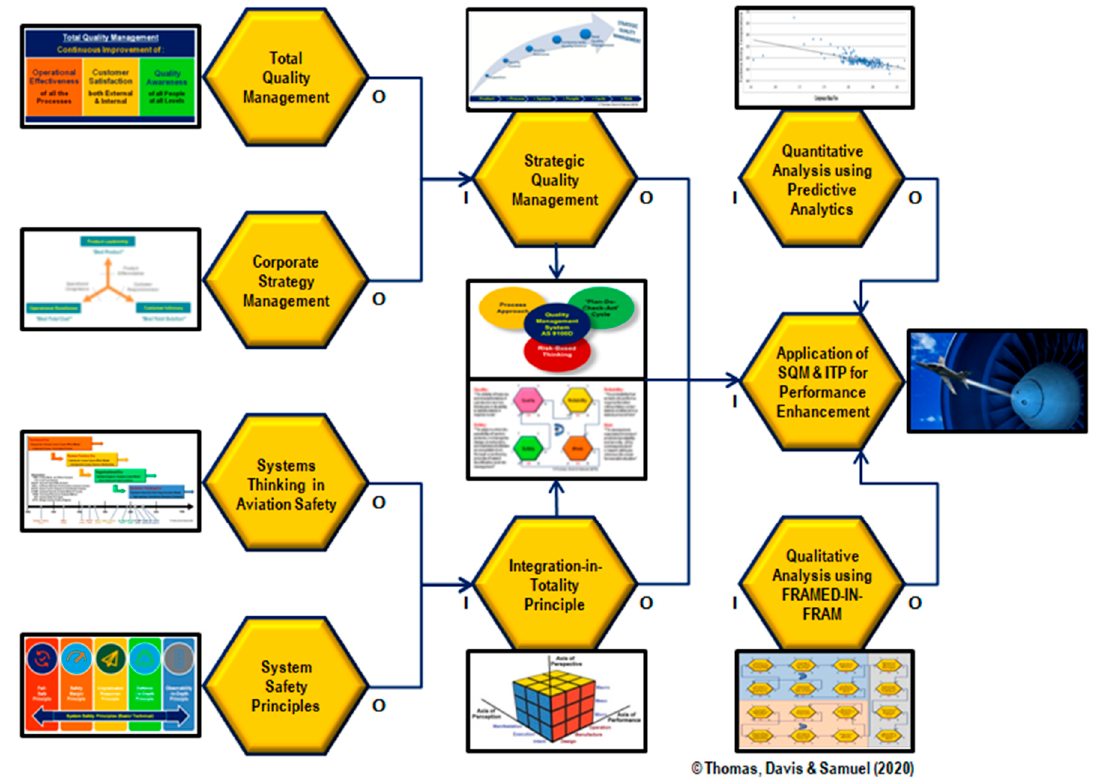
Figure 16. Theoretical Foundation of Applying Integration-in-Totality Principle in Strategic Quality Figure Management.